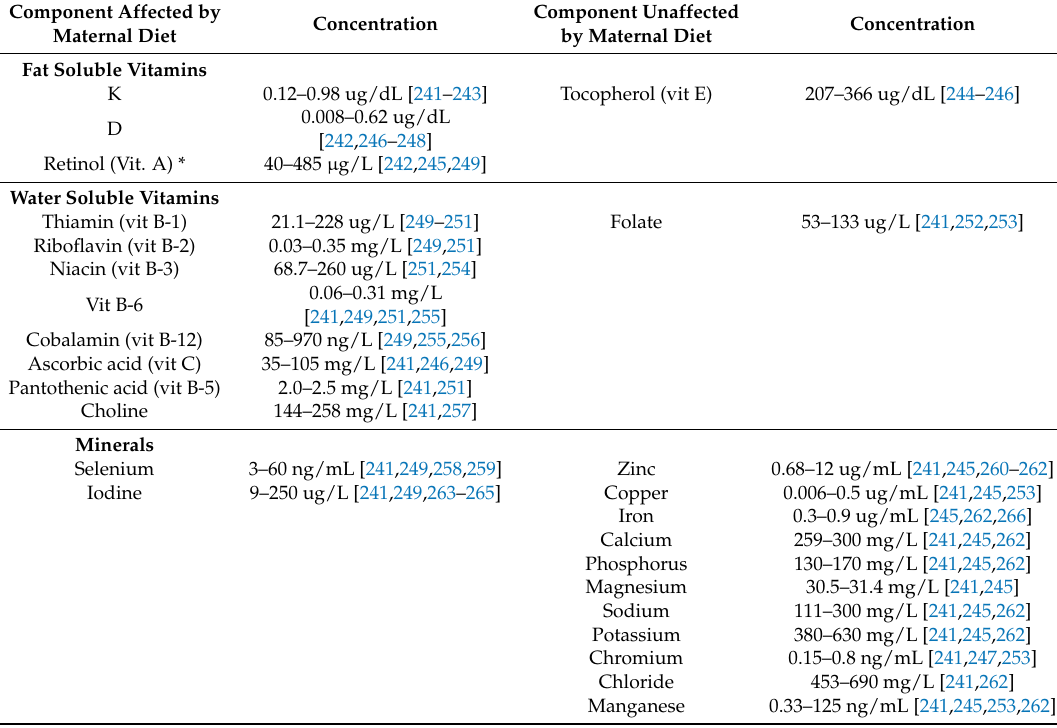
Table 3. Human milk micronutrients known to be influenced by maternal diet. The range of mean concentrations is given for mature milk. Reference [241]—”Handbook of Milk Composition” summarises milk composition up to approximately